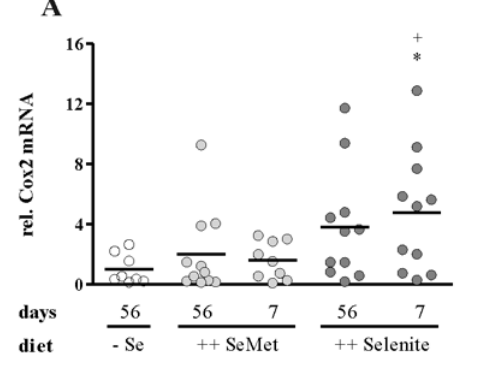
Figure 3. Intestinal inflammation is enhanced by short-term selenite supplementation. ( A ) The severity of inflammation was assessed by a score that was based on clinical, macroscopic and microscopic parameters. Each point represents one mouse. Lines indicate means. Significant differences were calculated by one-way ANOVA and Bonferroni’s posttest. ( B ) Body weight was monitored daily from the beginning of the DSS treatment until the end of the experiment. Significant differences were calculated by two-way ANOVA and Bonferroni’s posttest. ( C ) Colon length was measured from caecum to anus. Significant differences were calculated by one-way ANOVA and Bonferroni’s posttest. ( D ) Spleen weight was normalized to the body weight. Data are shown as the mean + SD. n = 12. Significant differences were calculated by one-way ANOVA and Bonferroni’s posttest. * p < 0.05 vs. − Se; # p < 0.05, ## p < 0.01 vs. ++ Selenite 56 days; + p < 0.05 vs. ++ SeMet 7